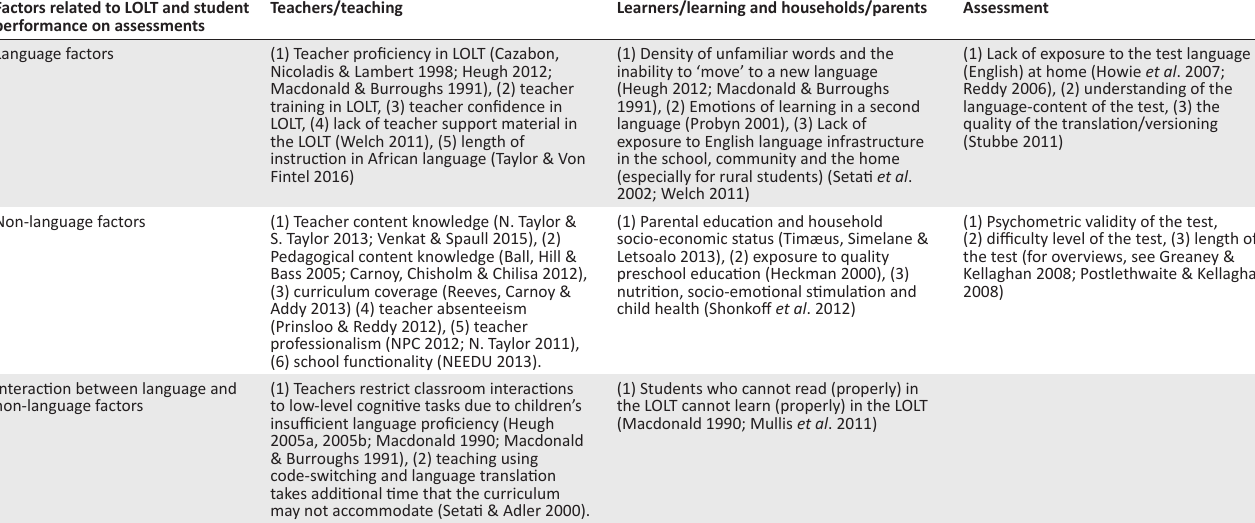
TABLE 1: Factors related to Language of Learning and Teaching and student performance on assessments. Factors related to LOLT and student performance on